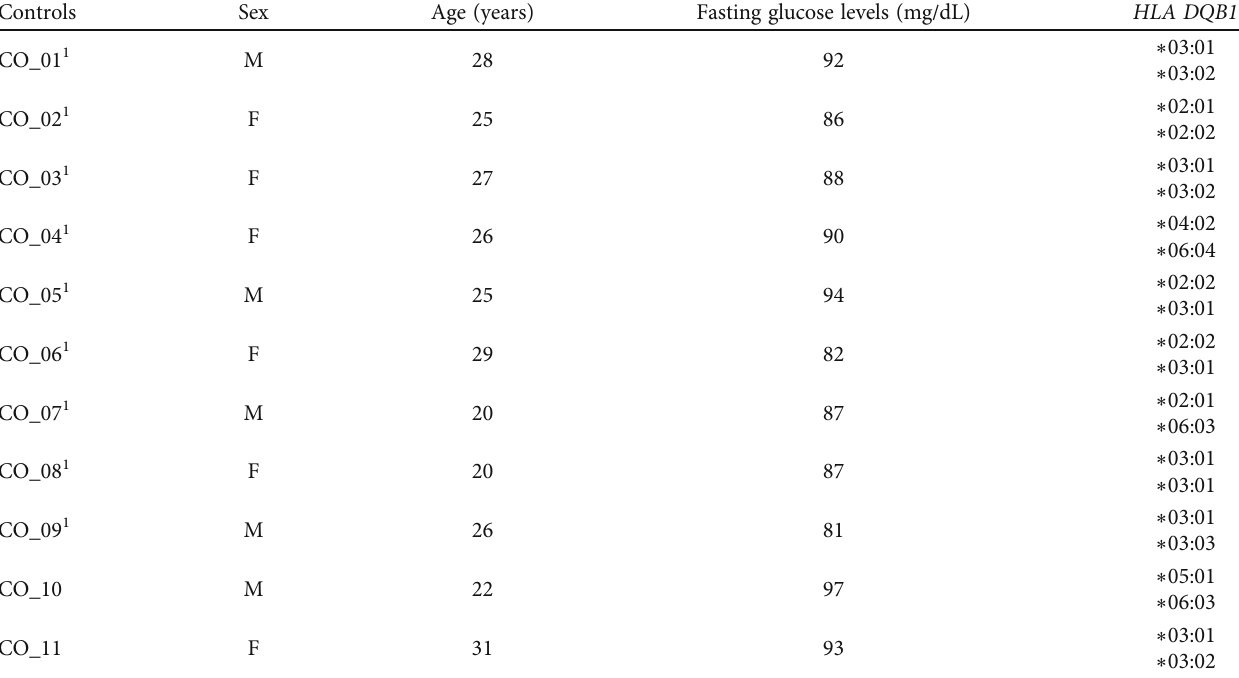
Table 2: Main characteristics of healthy individuals (control